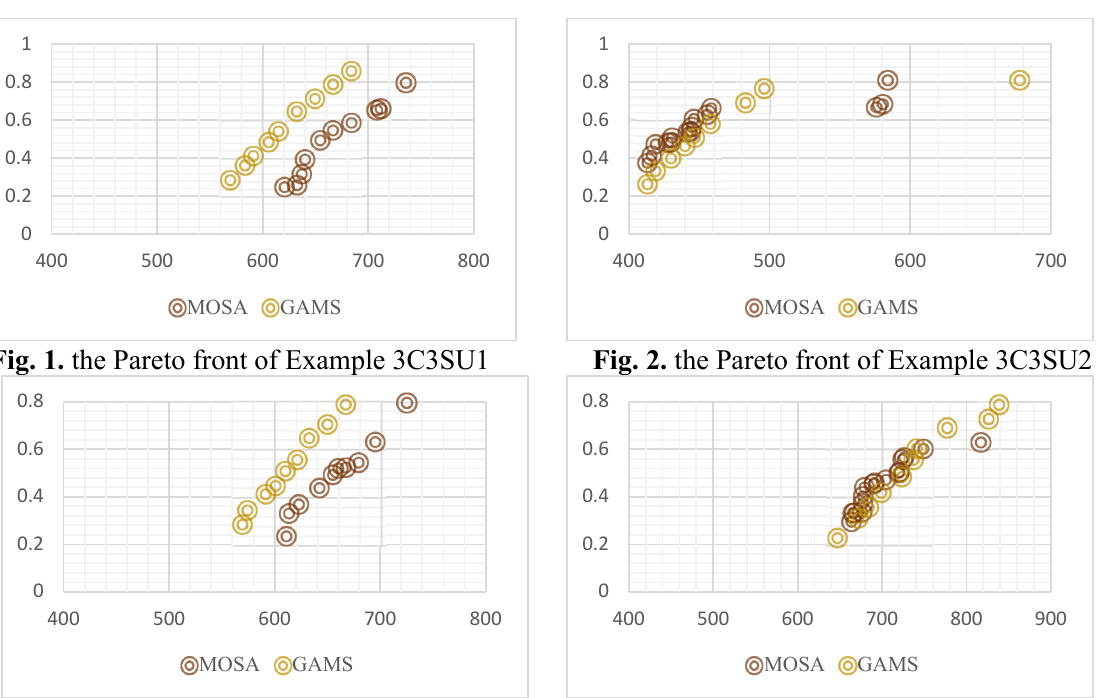
Fig. 3. the Pareto front of Example 3C3SU3 Fig. 4. the Pareto front of Example